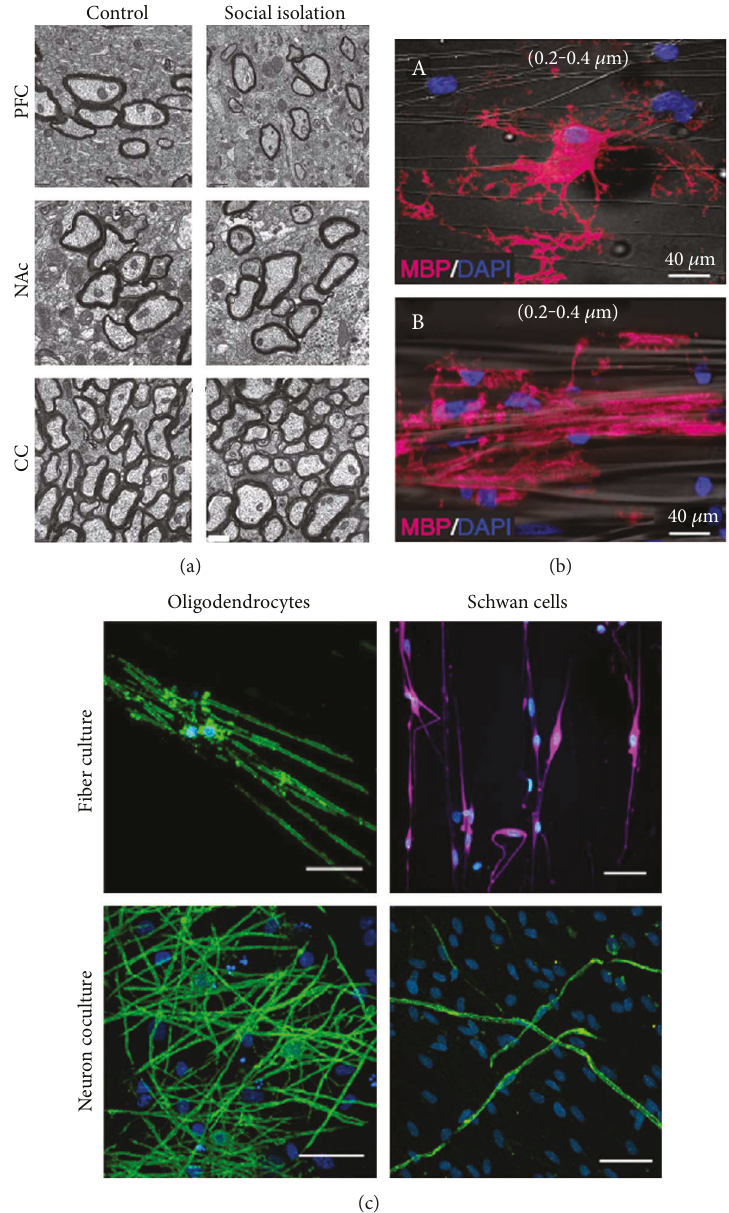
Figure 2: Axonal activity-dependent and activity-independent regulation of myelination. (a) Prolonged social isolation of adult mice induces hypomyelination in the PFC. Electron micrographs of axons in the PFC, nucleus accumbens (NAc), and corpus callosum (CC) from control and isolated mice (modi fi ed from Liu et al. [47], with copyright permission for reusing the fi gure panels). (b) The fi ber diameter is su ffi cient to initiate myelination in a neuron-free culture. To determine the minimum fi ber diameter at which oligodendrocytes commence wrapping in our system, Lee et al. analyzed oligodendrocytes cultured on nano fi bers ranging from 0.2 to 4.0 μ m in diameter and quanti fi ed the total number of MBP + segments normalized to the fi ber distribution on each coverslip. The minimum fi ber diameter threshold for oligodendrocyte myelination is approximately 0.4 μ m, which is supported by immunostaining of cultures for MBP and DAPI in the presence of small-diameter (A, 0.2 – 0.4 μ m) and large-diameter (B, 2.0 – 4.0 μ m) fi bers. Electron-spun polystyrene or poly-L-lactic acid (PLLA) nano fi bers with diameters ranging from 0.2 μ m to 4.0 μ m were engineered (modi fi ed from [62] with copyright permission for reusing the fi gure panels). (c) OLs have the unique, intrinsic capability to generate compact membrane sheaths and physiological internode lengths on micro fi bers. Confocal stacks of rat primary cortical OLs or Schwann cells cultured 14 or 21 days, respectively, on 1- 2 μ m micro fi bers or neurons (green: MBP, blue: Hoechst, and purple: S-100) (modi fi ed from Bechler et al. [64], with copyright permission for reusing the fi gure panels). Scale bars: 0.5 μ m in (a) and 40 μ m in (b) and